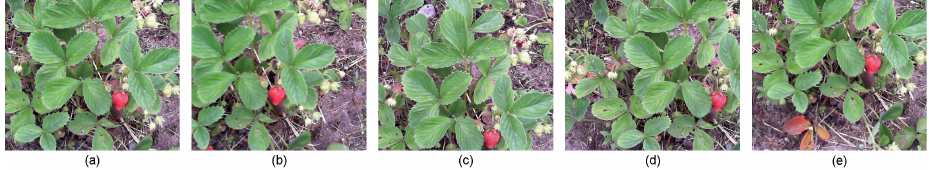
Figure 5. Images taken by EBCA used for creating data set of strawberry images: ( a ) central image, ( b ) right image, ( c ) up image, ( d ) left image and ( e ) bottom image.